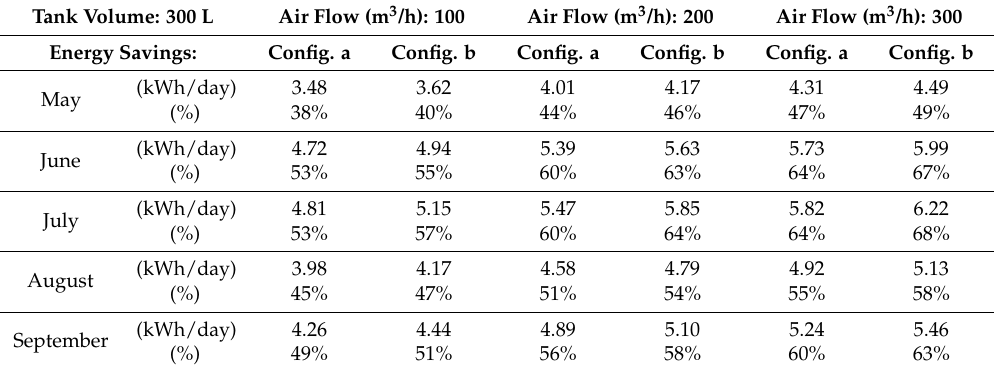
Table 6. Energy savings achievable during typical summer days through both configurations for a water tank of 300 L.